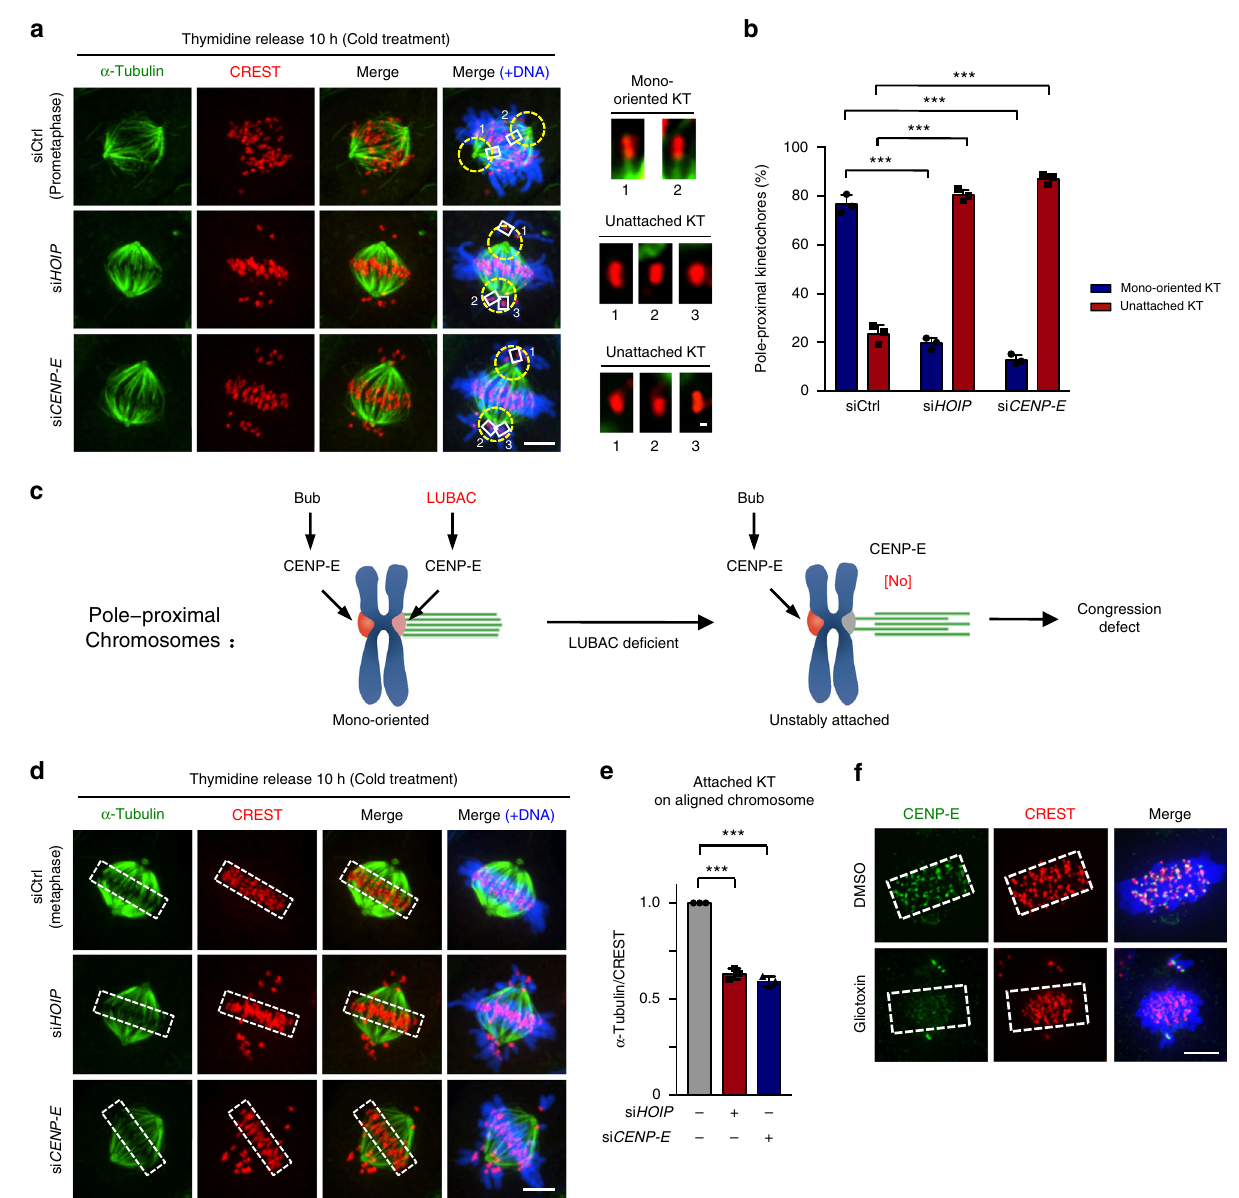
Fig. 3 LUBAC regulates KT-MT attachment, chromosome congression and alignment. a Cold-stable microtubules at pole-proximal kinetochores in control, HOIP or CENP-E depleted mitotic cells. Green, α -Tubulin; red, CREST; blue, DNA. Yellow circles indicate the pole-proximal region (an area covered by a circle with 2.5 μ m in radius centered around the spindle pole). Insets show mono-oriented or unattached pole-proximal kinetochores in each group. b Percentage of mono-oriented or unattached pole-proximal kinetochores in control ( n = 29 cells), HOIP ( n = 25 cells) or CENP-E ( n = 25 cells) depleted cells. c Model of LUBAC-dependent CENP-E localization at attached kinetochores on pole-proximal chromosomes regulating KT-MT attachment and chromosome congression. d Cold-stable microtubules on aligned chromosomes in control, HOIP or CENP-E depleted mitotic cells. Green, α -Tubulin; red, CREST; blue, DNA. White dashed boxes indicate areas where α -tubulin intensity was measured. e Relative intensity of cold-stable k- fi bers of the attached kinetochores on aligned chromosomes in control, HOIP or CENP-E depleted cells in d . n = 15 cells per group. The average α -tubulin/CREST ratio of each group was normalized to control cells. f CENP-E kinetochore localization in HeLa cells treated with 100 nM proteasome inhibitor Velcade for 2 h, and then released into medium containing DMSO or 1.2 μ M Gliotoxin (LUBAC inhibitor) for 30 min. Green, CENP-E; red, CREST; blue, DNA. Dashed boxes, regions of aligned chromosomes. Data are presented as mean ± s.d. of three independent experiments ( b and e ). Dashed boxes, regions of aligned chromosomes ( d and f ). *** P < 0.001; two-sided Student ’ s t -test. Scale bars, 5 μ m (main image) and 0.3 μ m (magni fi ed